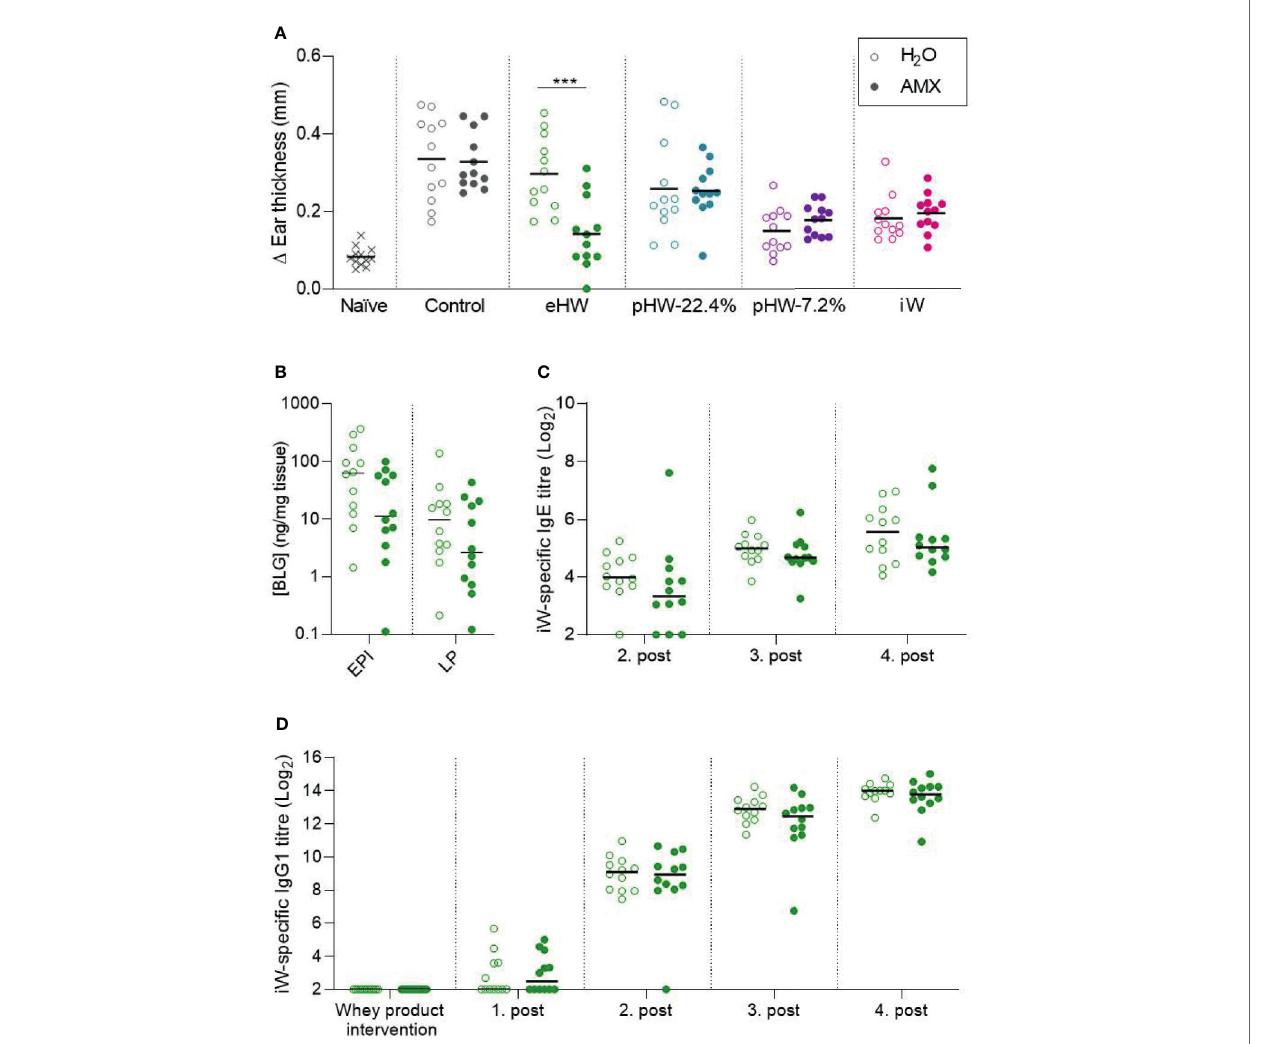
FIGURE 6 | Effect of amoxicillin on the preventive capacity of the whey products. Ear swelling after intradermal injection of intact whey product on Day 63 in water (H 2 O, open symbols) and amoxicillin (AMX, closed symbols) in rats administered with extensively (eHW), partially hydrolysed (pHW-22.4% and pHW-7.2%) or intact (iW) whey products or water as control (A) . b -lactoglobulin (BLG) concentration in small intestine epithelium (EPI) and lamina propria (LP) after oral challenge with iW protein (B) , iW-speci fi c IgE titres (C) , and iW-speci fi c IgG1 titres (D) . Sub fi gures (B – D) only show results for the eHW group. Each symbol represents a single rat and horizontal lines indicate mean (A) or median (B – D) values. Statistically signi fi cant differences are indicated as ***p ≤